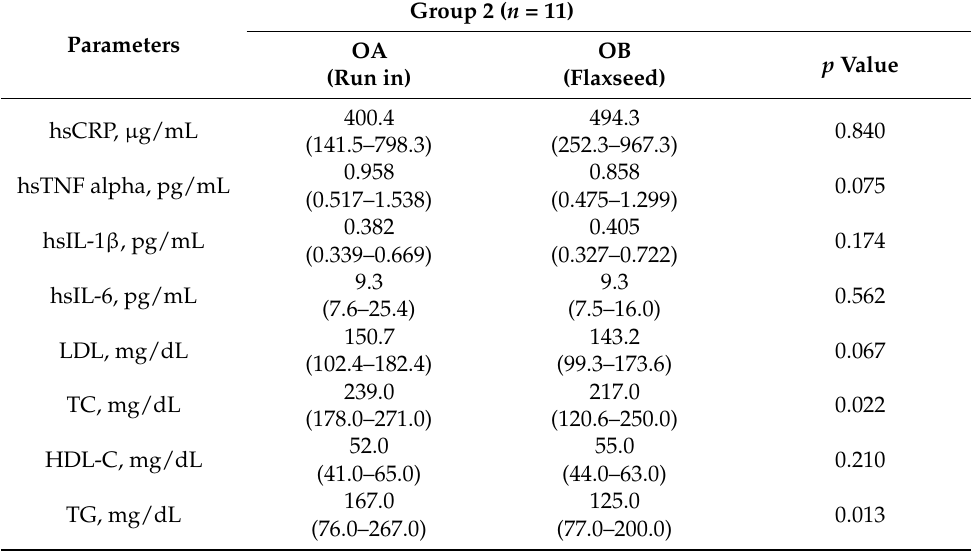
as medians and range. Abbreviations: hsIL-6, high-sensitivity IL6; hsIL-1beta, high-sensitivity interleukin 1 beta; hsCRP, high-sensitivity CRP; hsTNF alpha, high-sensitivity TNF alpha; HDL, high density lipoprotein cholesterol; LDL, low density lipoprotein cholesterol; TC, total